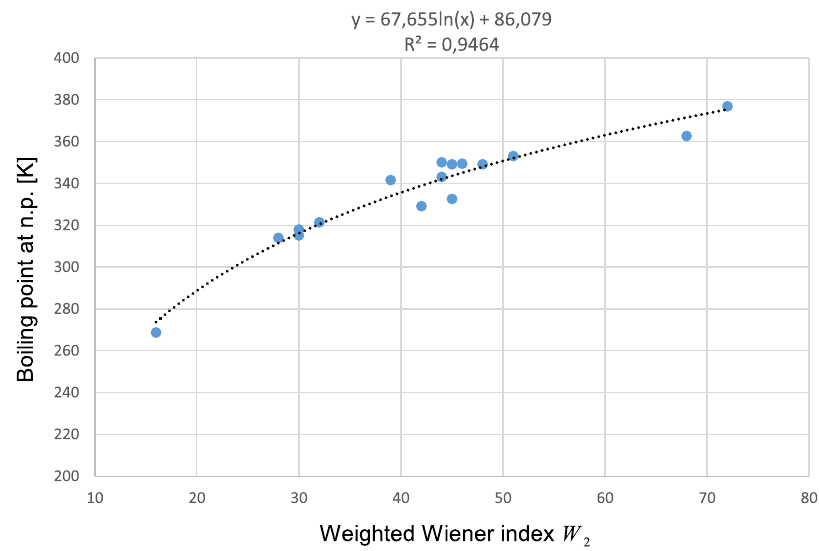
Figure 5. Weighted Wiener indices W 2 and boiling points for the alkadienes in the training set.